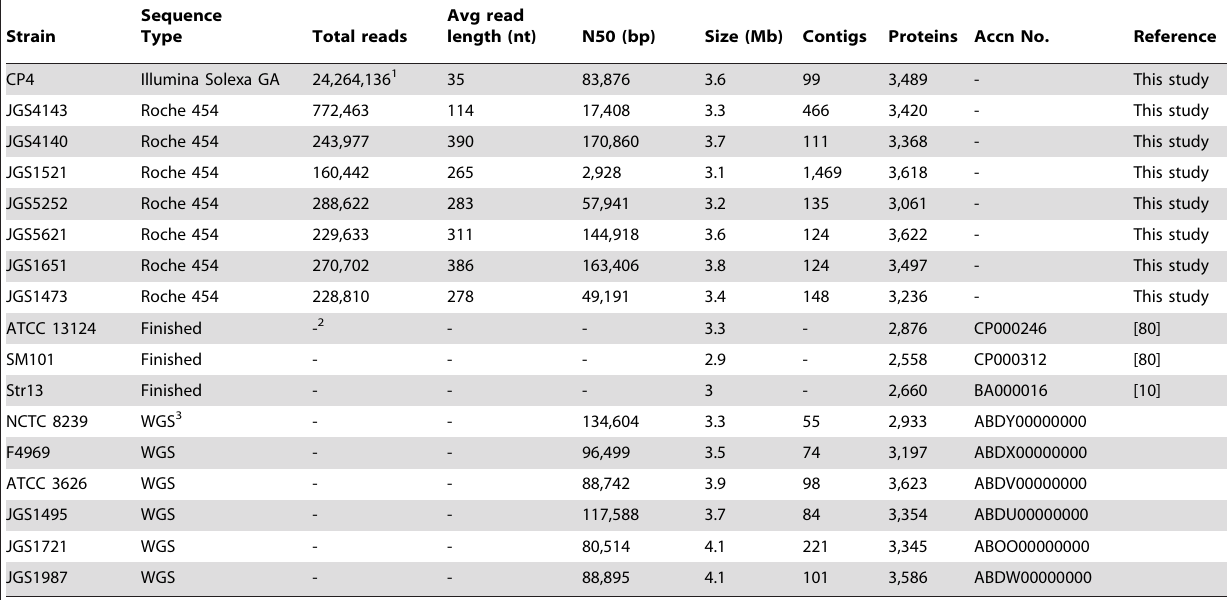
Table 2. Summary of C. perfringens genome sequences used in this study.